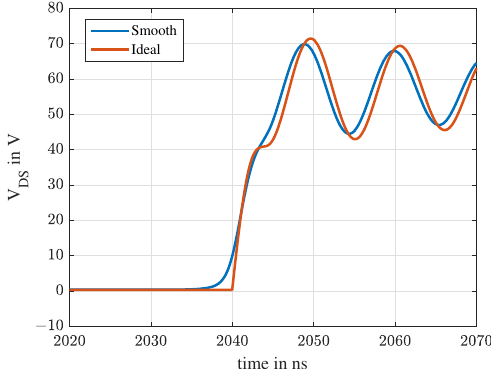
Figure 17. Drain -Source voltage of the high side (HS) transistor (see Figure 15) with an ideal and smooth switching behavior.